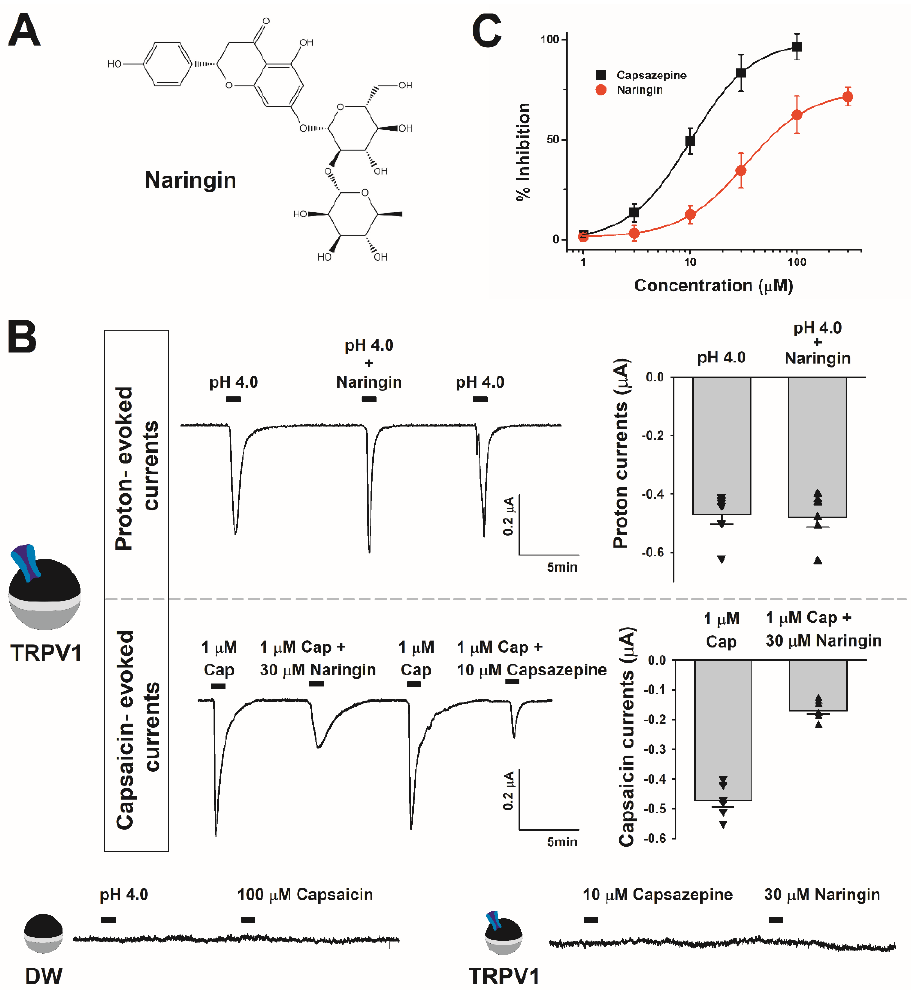
Figure 2. Selective inhibitory effect of capsaicin on TRPV1 and the chemical structure of naringin: ( A ) 2D structure of naringin. ( B ) Different inhibitory effects of naringin on proton-evoked currents and capsaicin-evoked currents. In the imaging of proton-evoked currents, naringin was used at a concentration of 30 µ M. The TRPV1 oocyte image shows currents measured by injecting TRPV1 mRNA into oocytes. The distilled water-treated oocyte image shows currents measured by injecting tertiary distilled water into oocytes. Cap is capsaicin. Capsazepine is a published antagonist of TRPV1. The treatment was carried out at a pH of 4.0 using the ND96 buffer. ( C ) The histogram shows the degree of inhibition of TRPV1 inward current by naringin. The data are indicated as the mean ± S.E.M ( n = 10–13 from six different frogs).